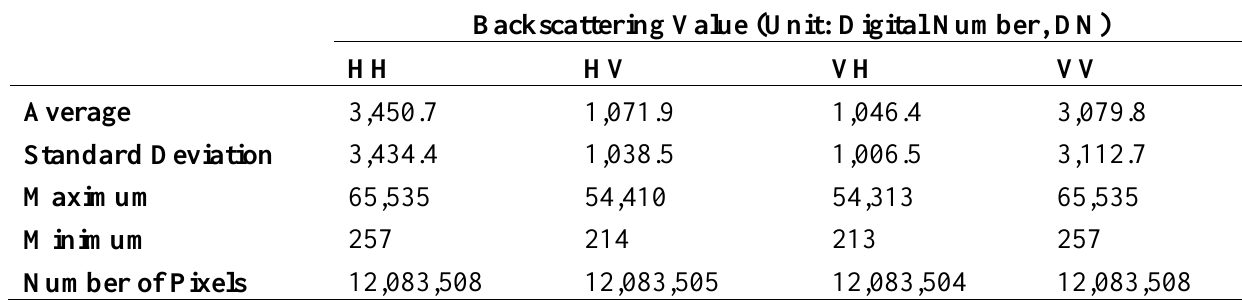
Table 2. Basic statistics for the whole area of backscattering values in each direction of polarization.